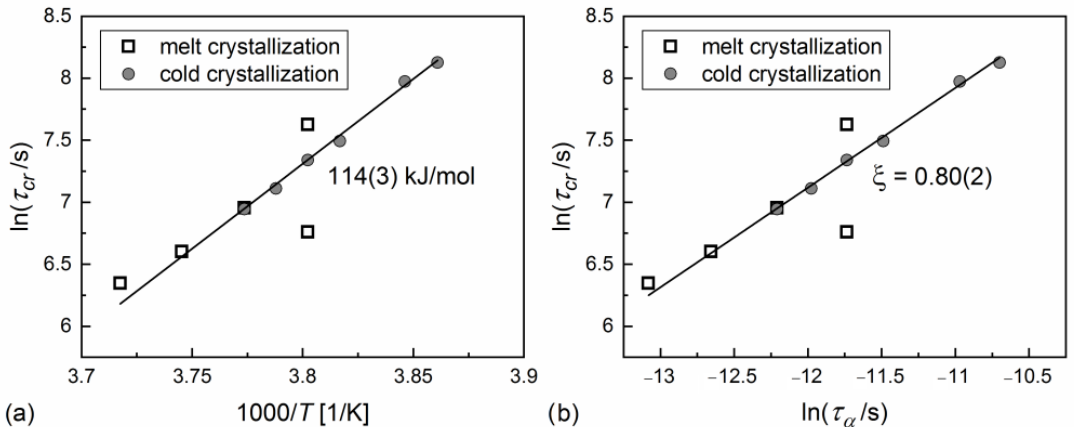
Figure 7. Arrhenius plot of the characteristic time of the isothermal crystallization of 7HH6 ( a ) and coupling between the characteristic time of crystallization and relaxation time of the α -process, determined for the 259–269 K range from the parameters of VFT formula ( b ).